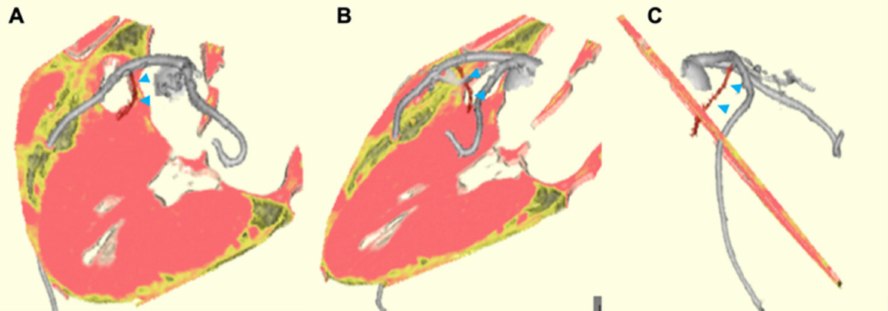
Figure 4. Three-dimensional CT images for the assessment of appropriate septal branch coronary artery for patients with significant left ventricular outflow tract obstruction planned for PTSMA. The arrowheads indicate the septal branch. CT = computed tomography, PTSMA = percutaneous transluminal septal myocardial alcohol ablation. D-dimensional views of the first major septal branch from different angles ( A – C ).